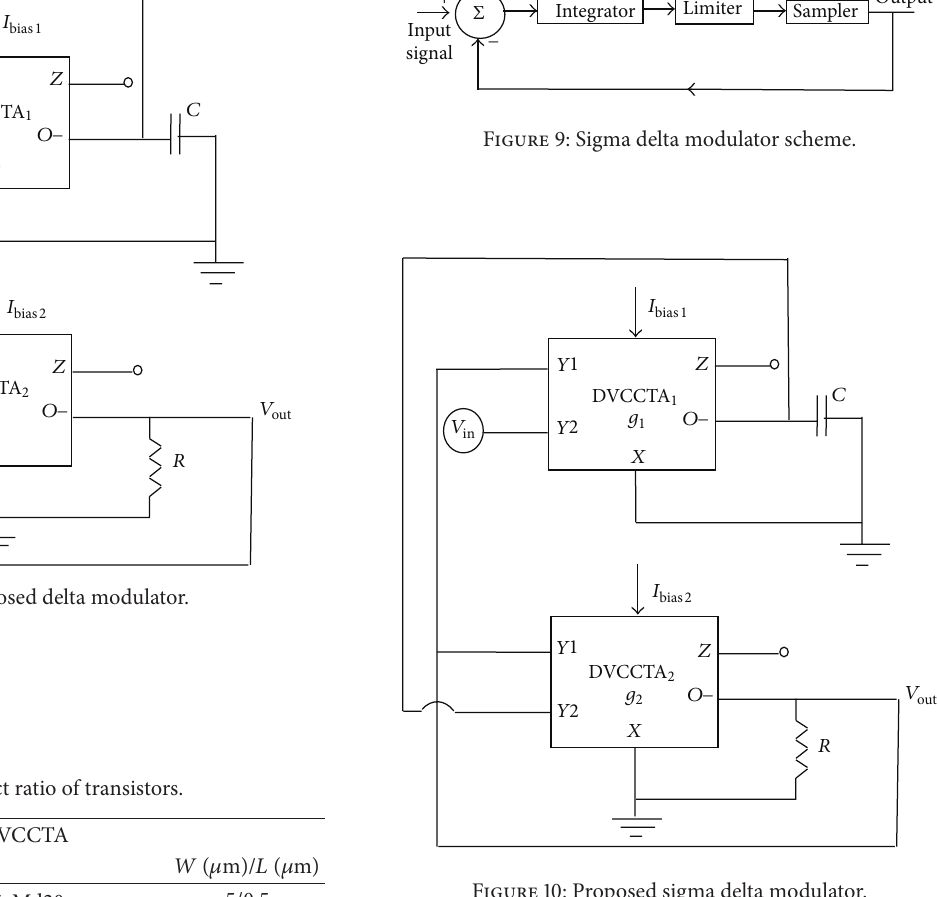
Figure 10: Proposed sigma delta